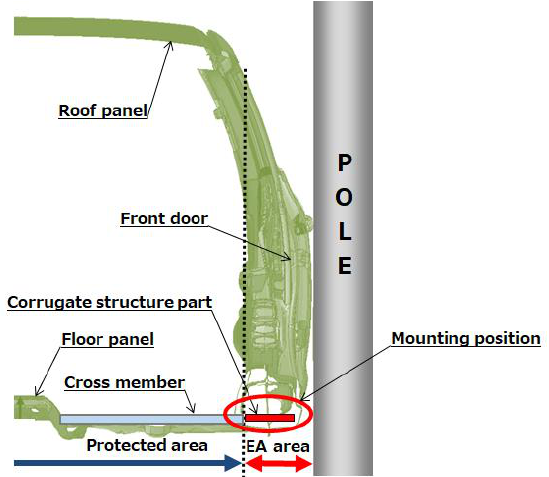
Figure 5. Layout of support structure of vehicle body.